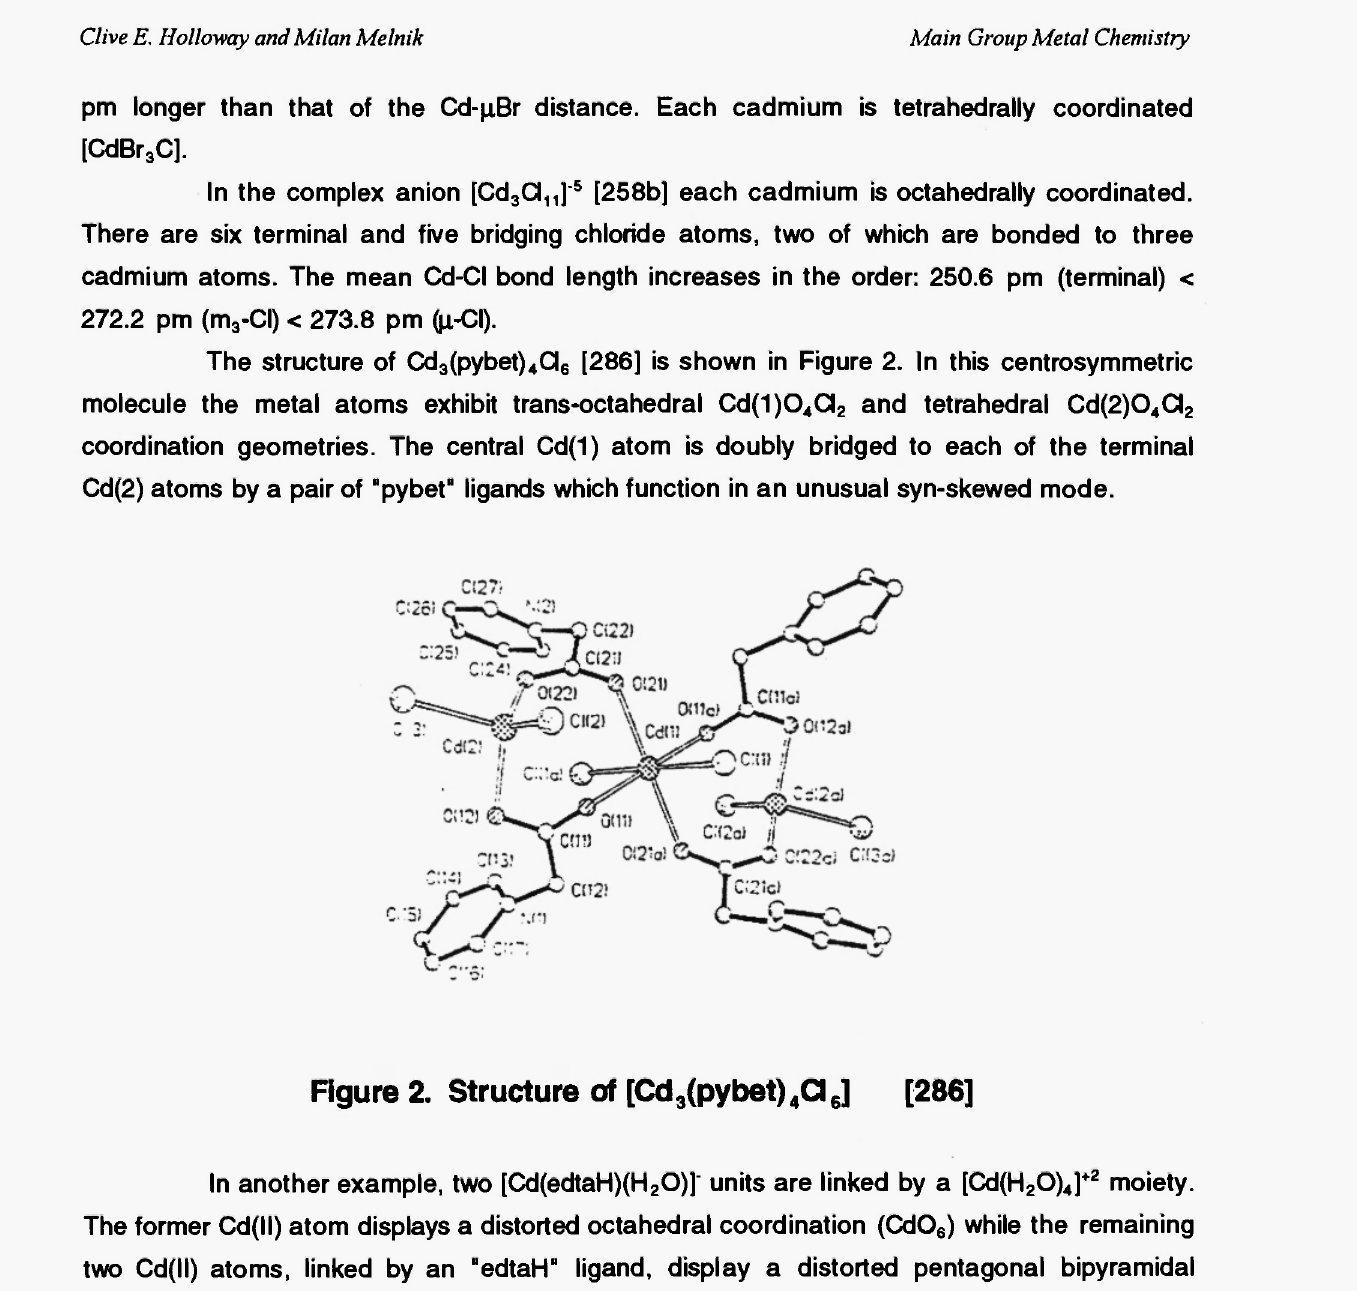
Figure 2. Structure of [Cd